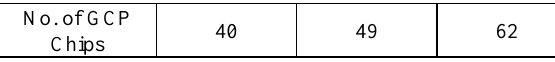
Table 3. Specification of Kompsat-3A images used.